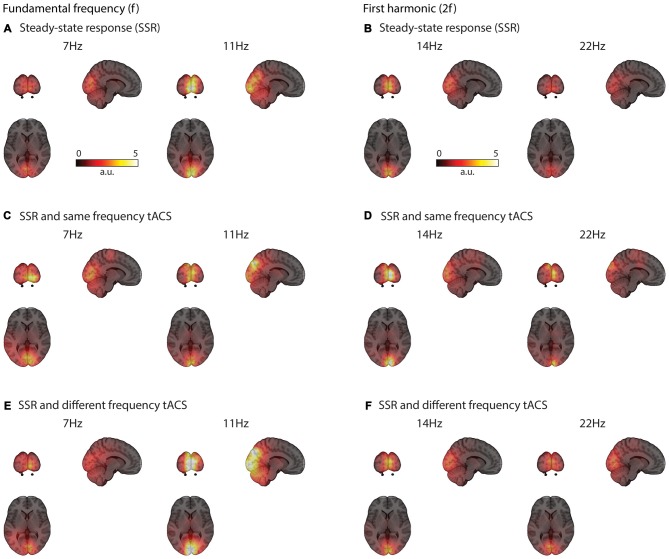
Grand average functional brain activity (power) evoked by the visual flicker mapped onto a standard montreal neurological institute (MNI) brain. SSR strongly activates occipital regions (A) The activation patterns are similar even with concurrent tACS stimulation at the same (C) and different-frequency (E) Similar occipital regions are active at the second harmonic (2f) of the SSR (B,D,F).